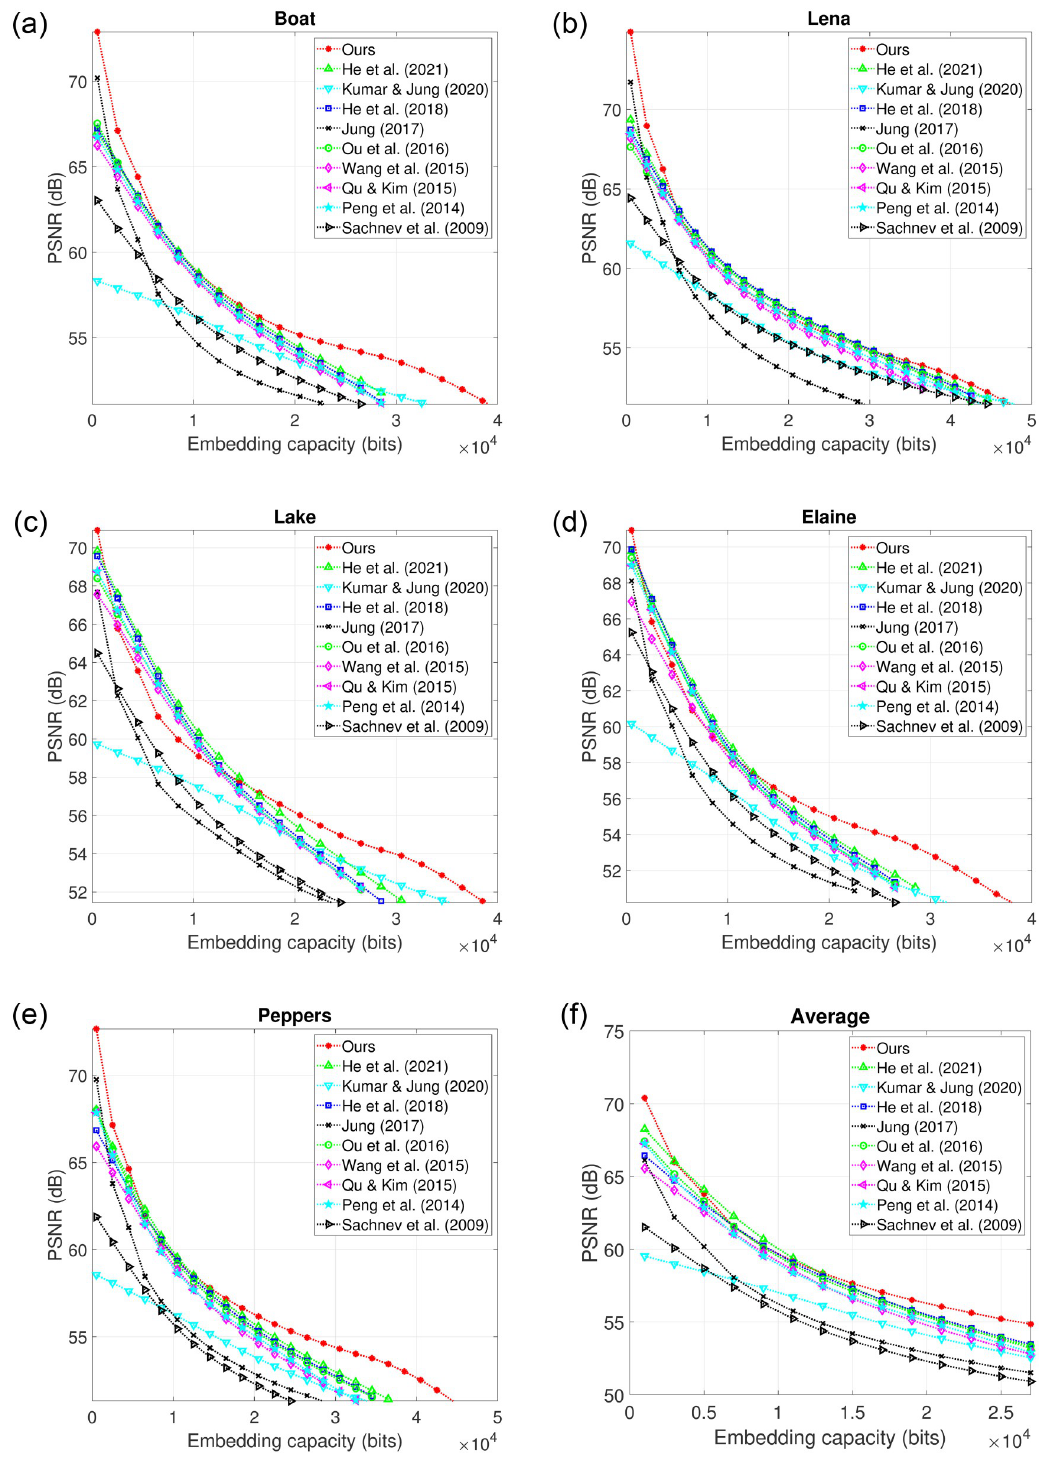
Fig 8. Overall embedding rate distortion performance comparison with the popular and recent RDH schemes of He et al . (2021) [54], Kumar & Jung (2020) [53], He et al . (2018) [38], Jung (2017) [36], Ou et al . (2016) [34], Wang et al . (2015) [33], Qu & Kim (2015) [32], Peng et al . (2014) [30] and Sachnev et al . (2009) [19].